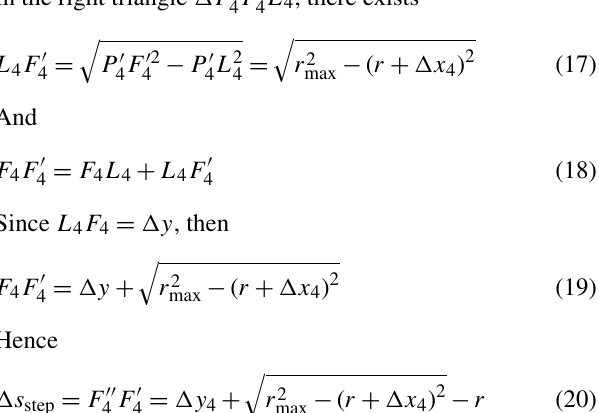
is the farthest foothold without trunk 4